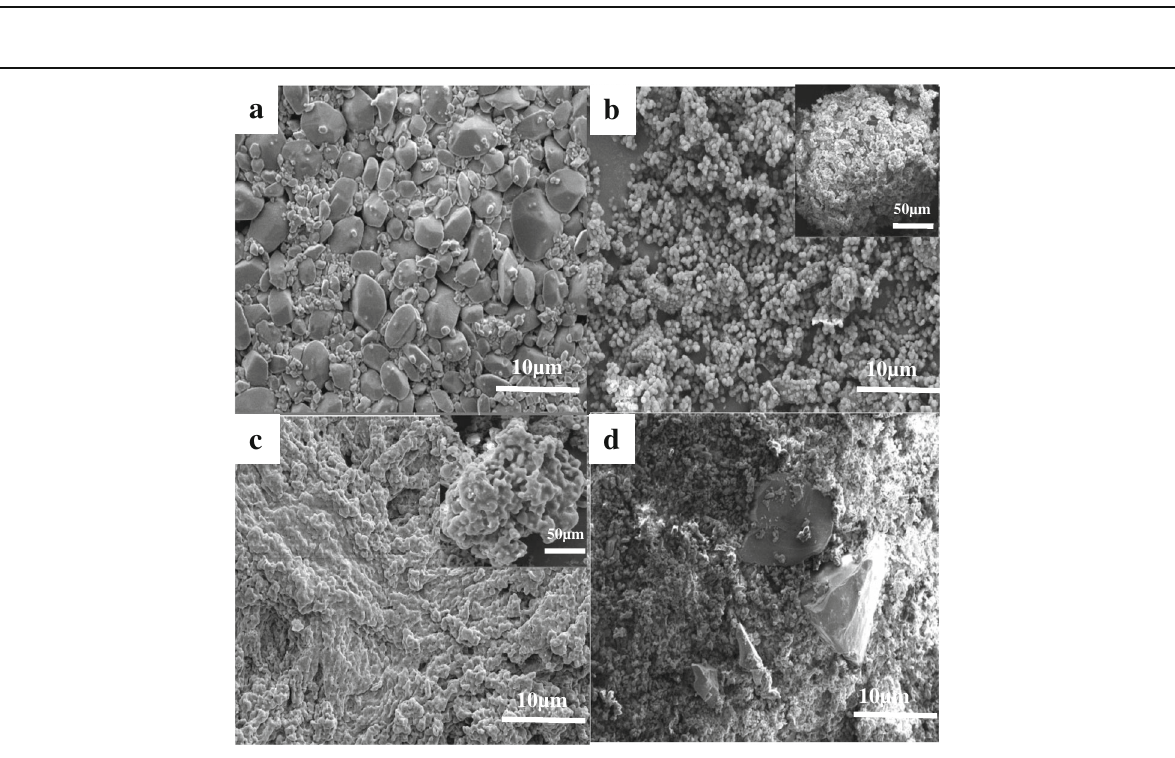
Fig. 5 SEM images of the uncoated CL-20 ( a ), CL-20/MUF-1 ( b ), CL-20/MUF-2 ( c ), and CL-20/MUF-3 ( d ); corresponding images with low magnification are inserted